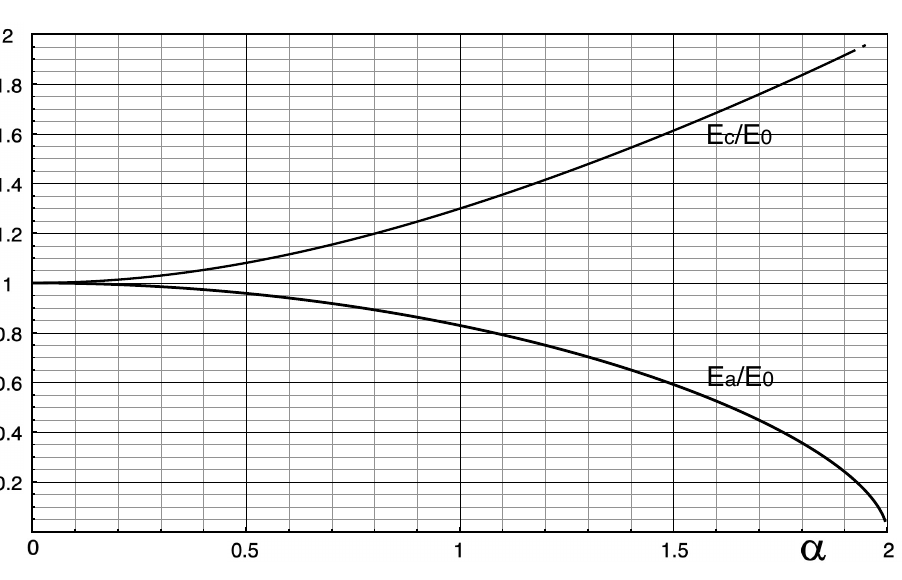
Figure 1. Normalized electric field at the anode E a / E ◦ and cathode E c / E ◦ as a function of the dimensionless parameter α . Reproduced from reference [6].